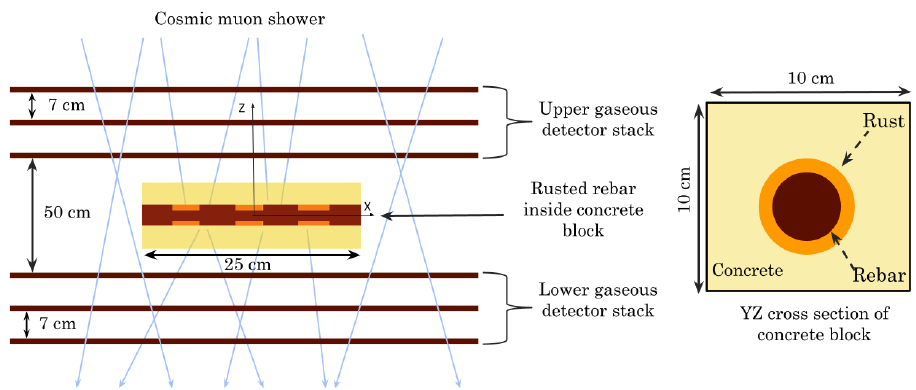
Figure 7. Simulation setup for a rusted rebar. The rusted region (orange) of the steel rebar (brown) is enclosed within the concrete block (yellow).